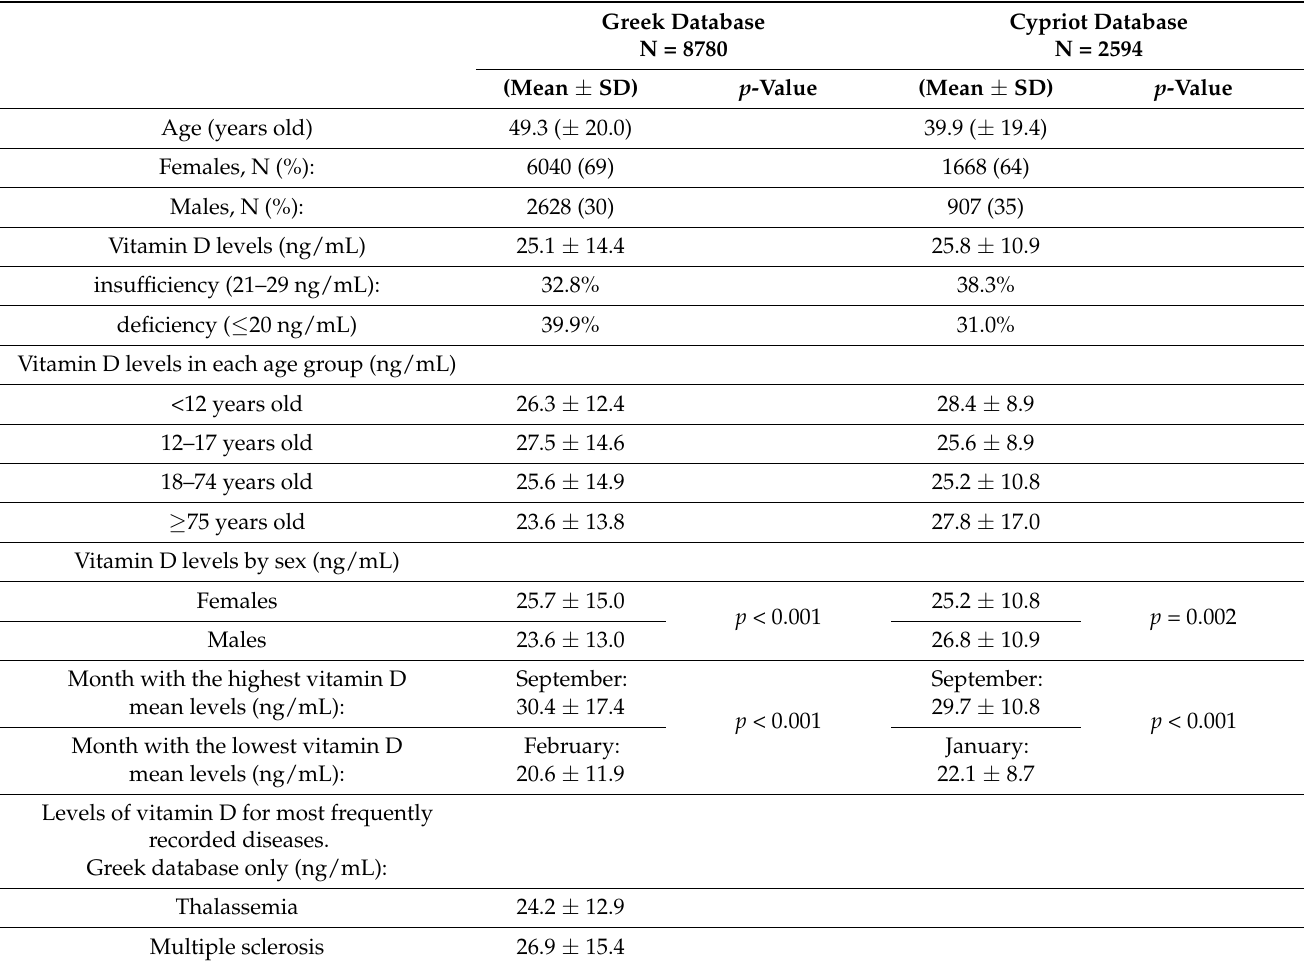
Table 1. Descriptive characteristics and results for the Greek and Cypriot Database and multivariate analysis